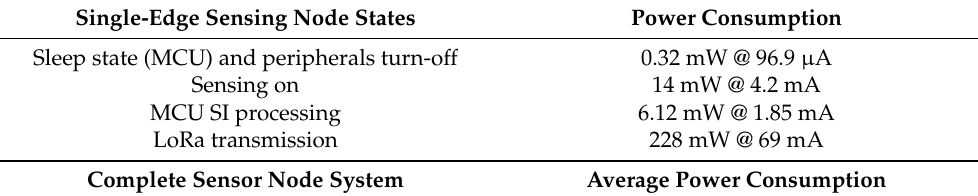
Table 2. Power consumption analysis of the edge-computing wireless sensing node. Single-Edge Sensing Node